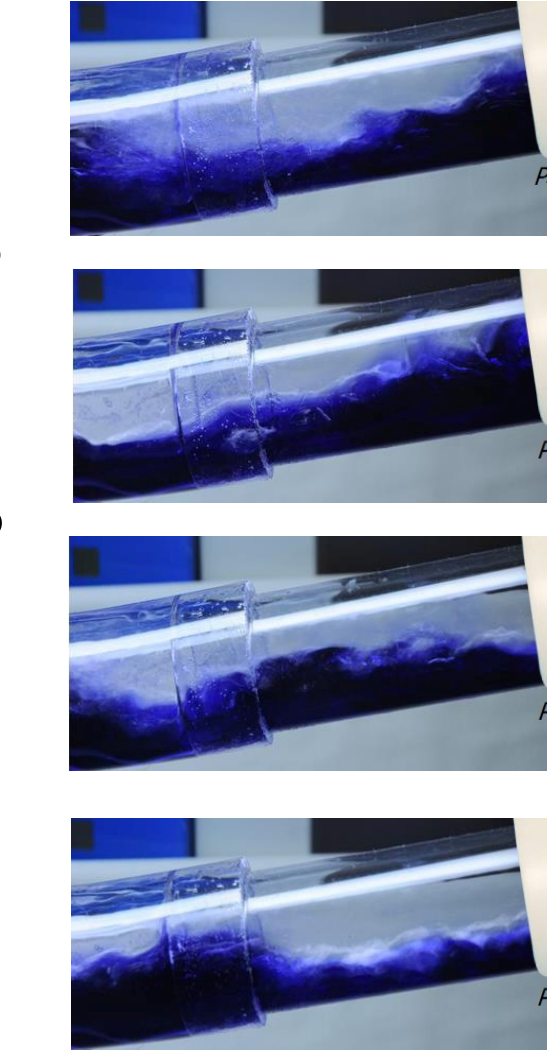
Figure 13. Verification of slug flow pressure model with an inclination of 20°.